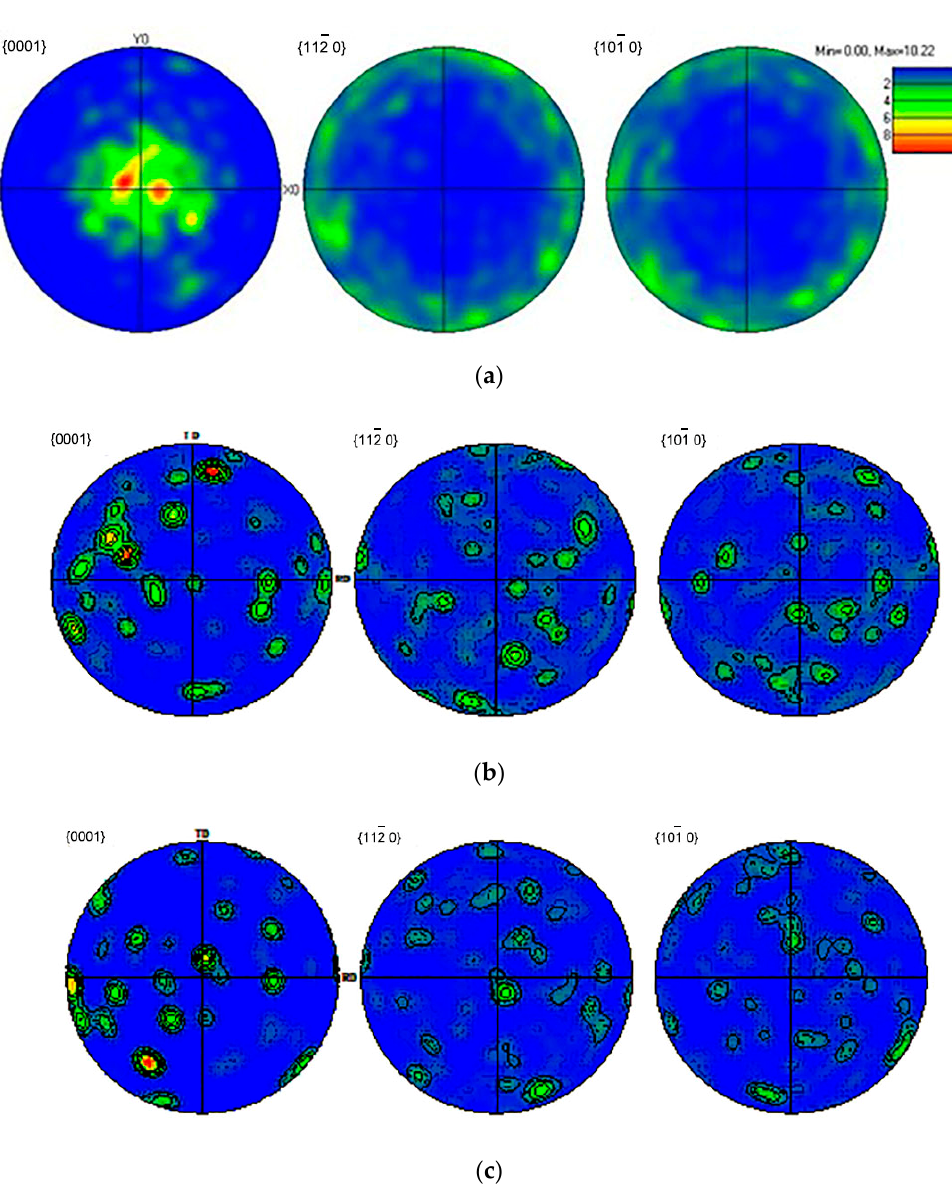
Figure 8. Pole figures of BM ( a ), weld metal at 3 mg/cm 2 without magnetic field ( b ), and weld metal at 3 mg/cm 2 with magnetic field ( c ).